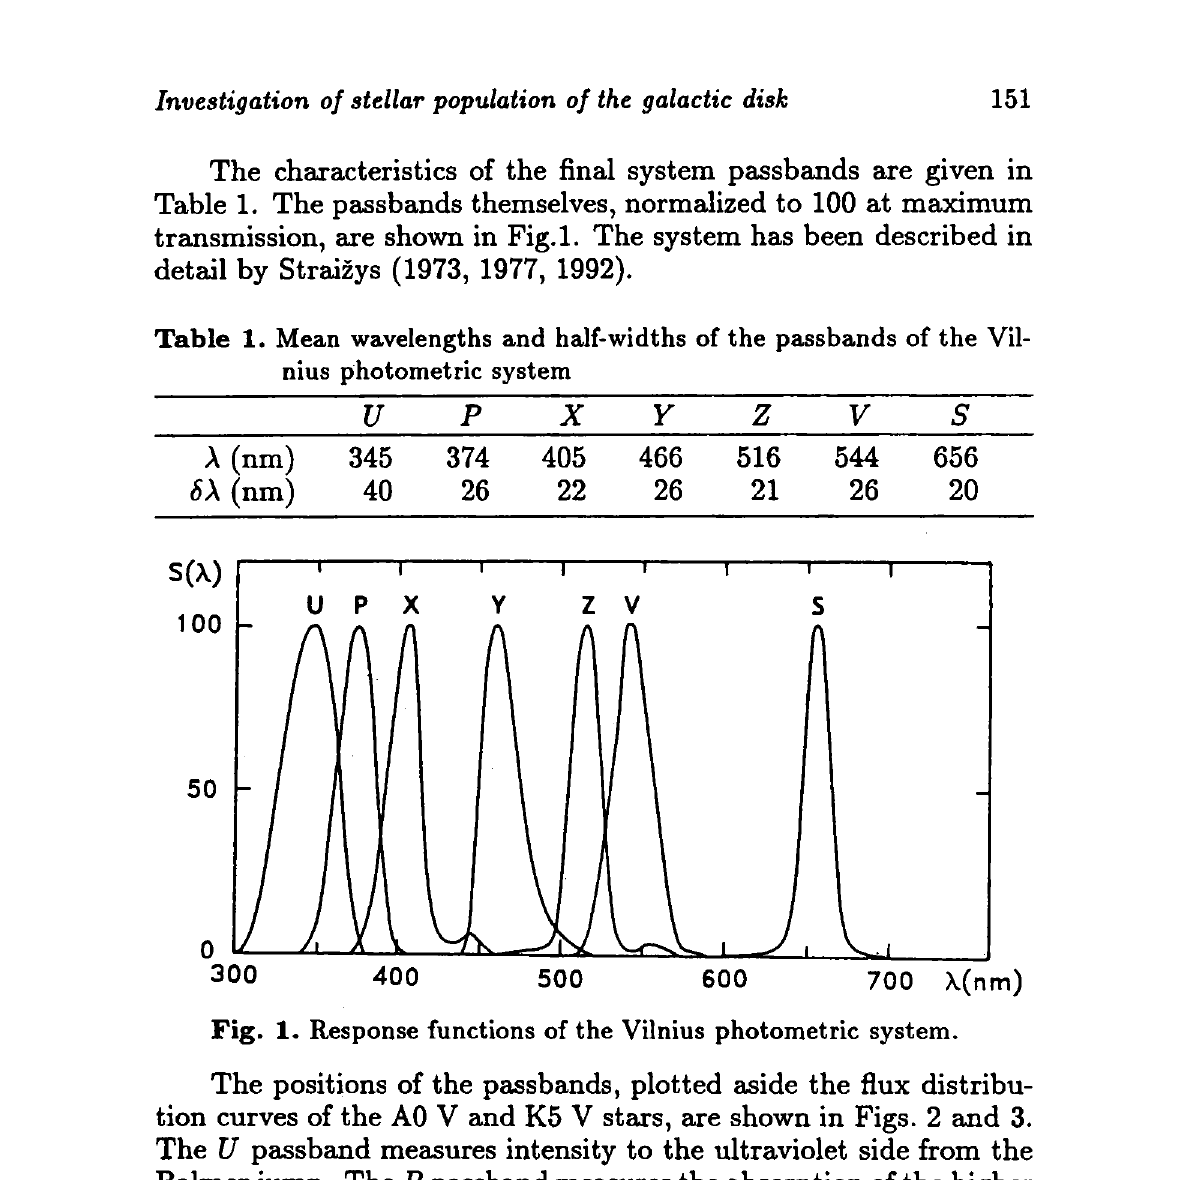
Table 1. Mean wavelengths and half-widths of the passbands of the Vil-